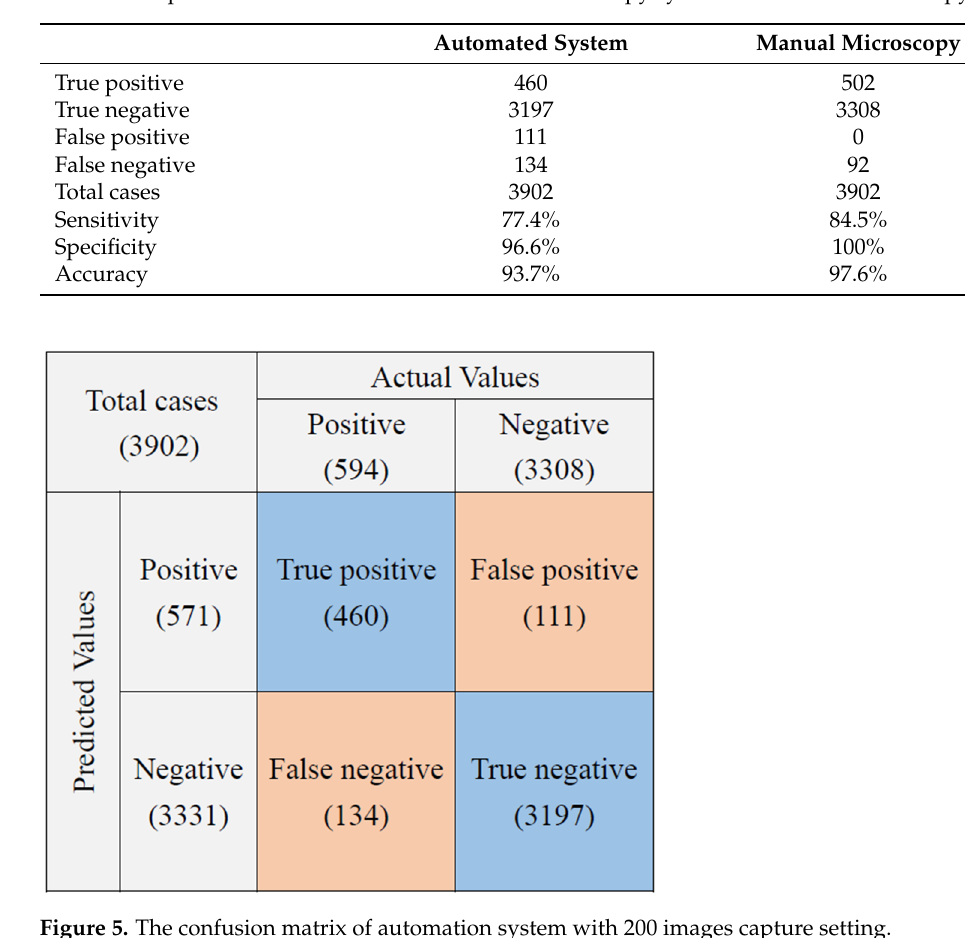
Table 3. The performance of automated TB smear microscopy system and manual microscopy.